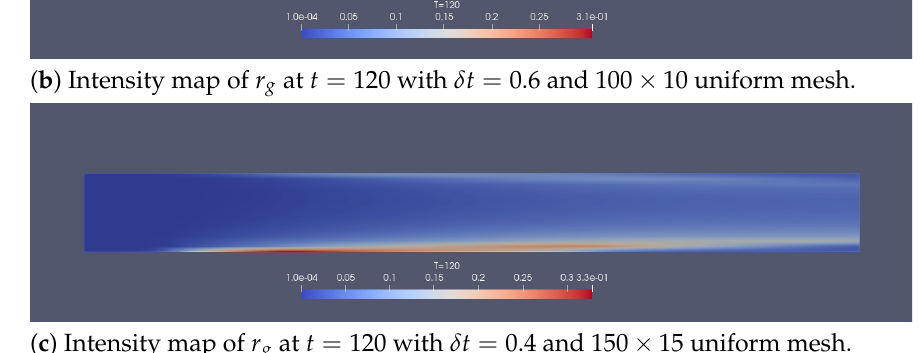
( c ) Intensity map of r g at t = 120 with δ t = 0.4 and 150 × 15 uniform mesh.